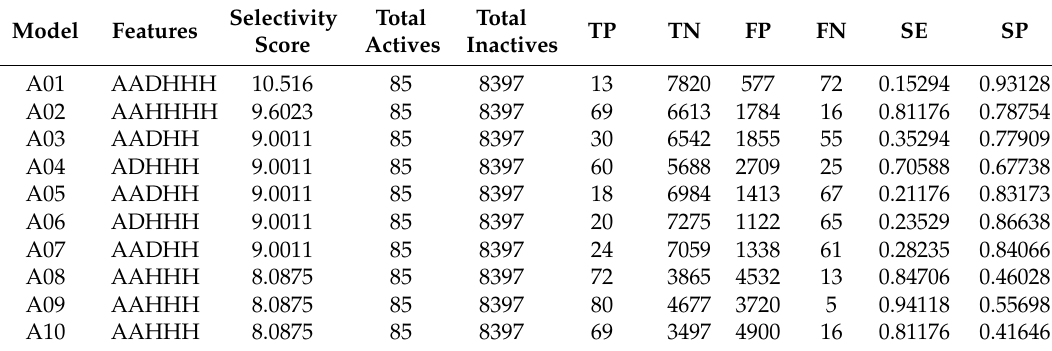
Table 1. Features, selectivity scores, and validation results of the receptor-ligand-based pharmacophore models. TP, true positive; TN, true negative; FP, false positive; FN, false negative; SE, sensitivity; SP,